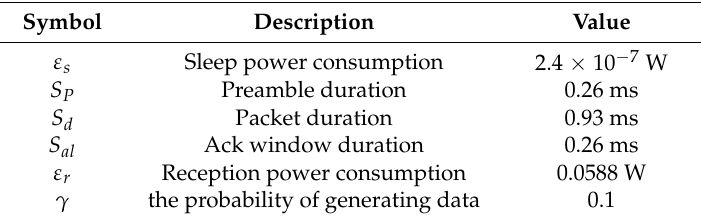
Table 1. Parameters of network.